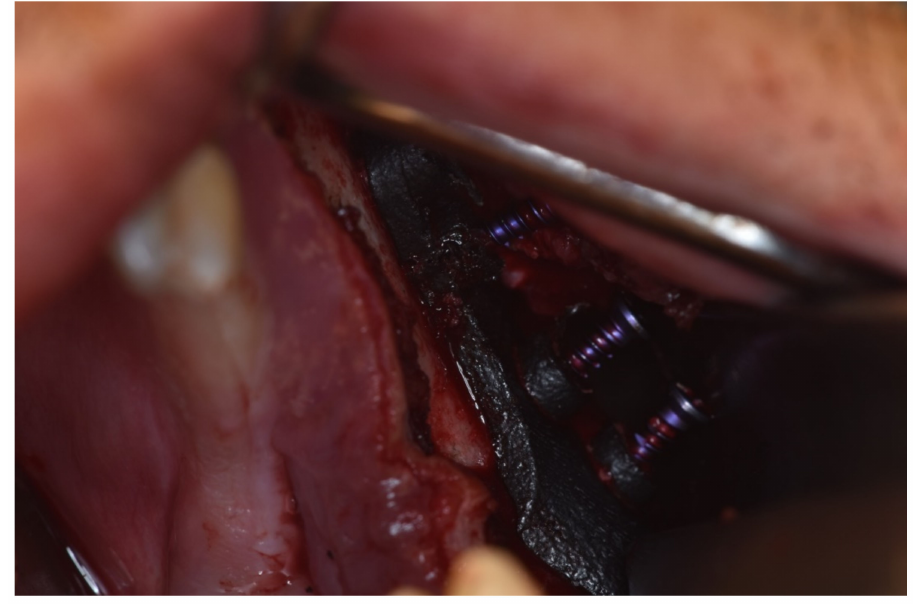
Figure 8. Implanting screws.